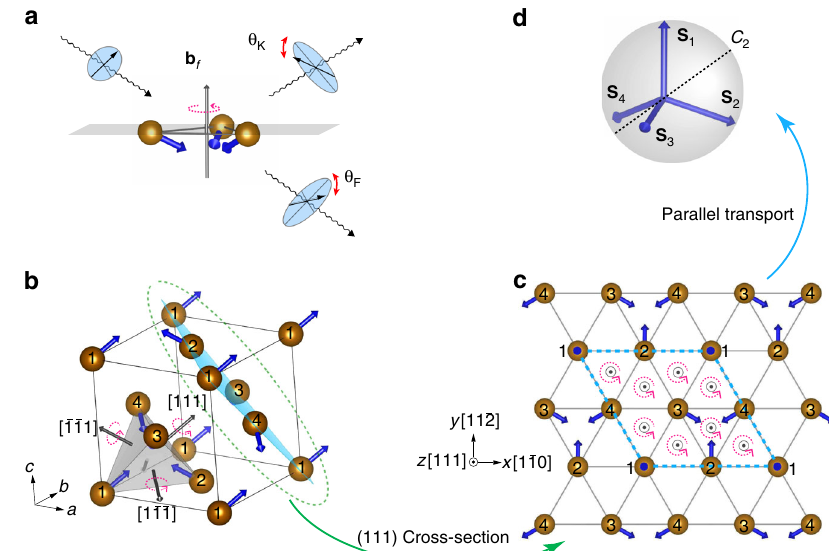
Fig. 1 Topological light – matter interactions in chiral magnets. a Sketch of topological light – matter interactions in a minimal chiral magnet comprising three neighboring noncoplanar spins. b is the fi ctitious magnetic fl ux generated by the fi nite scalar spin chirality. Topological magneto-optical Kerr and f Faraday effects are induced by the fi ctitious magnetic fl ux b rather than by the nonzero net magnetization. b The 3 Q noncoplanar antiferromagnet on a 3D f fcc lattice. The numbers 1 – 4 label the four magnetic sublattices, which are the corners of a tetrahedron (gray color). Blue and gray arrows indicate the directions of the localized spin S i and the fi ctitious magnetic fl ux b , respectively. c The 3 Q nc-AFM on a 2D triangular lattice. It is the (111) cross-section of f the 3D fcc lattice, indicated by cyan color in b . Dashed cyan lines mark the 2D unit cell. (cid:5) indicate the directions of the b on each triangular plaquette. f d The unit sphere is spanned by the spins on four sublattices that are parallel transported to have a common origin. The dashed line indicates one of the C 2 rotation axes in spin